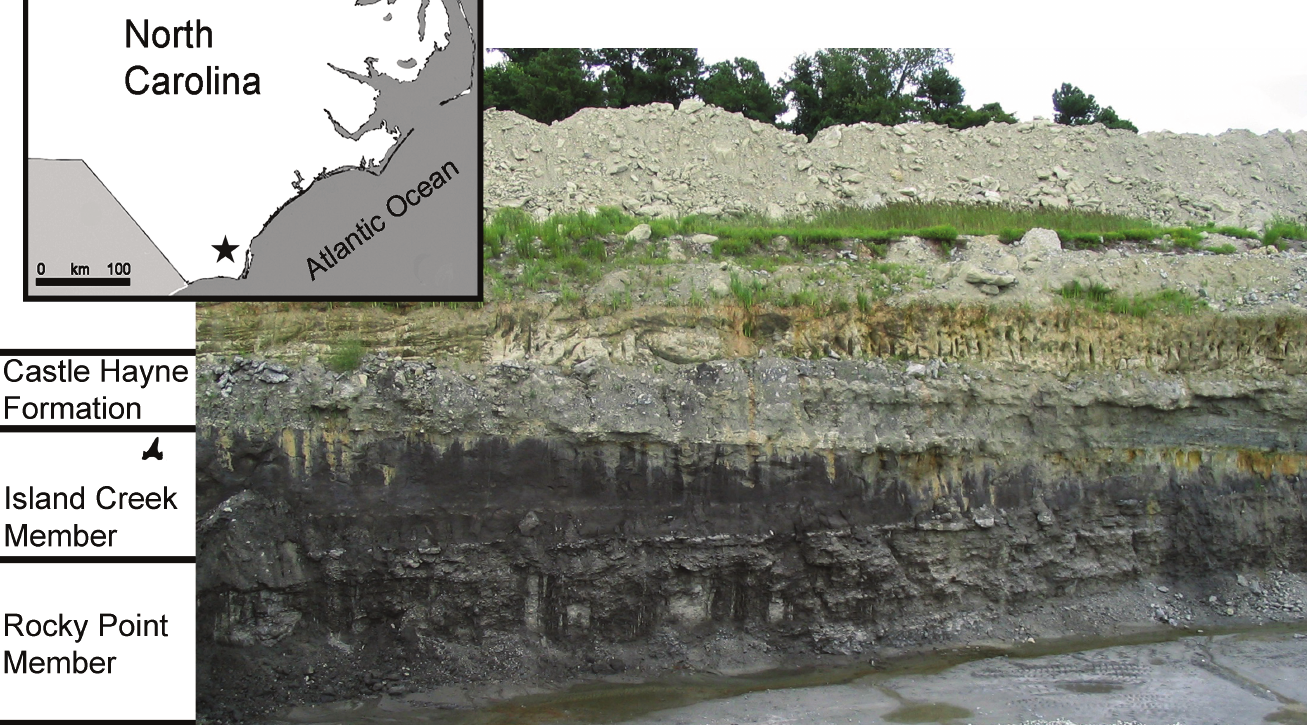
Figure 1. Map and stratigraphy of the Martin-Marietta Castle Hayne Quarry. Note the Island Creek Member pinches out to the right in this image. Silhouette of shark tooth represents fossil occurrence within the upper 0.4 m of the